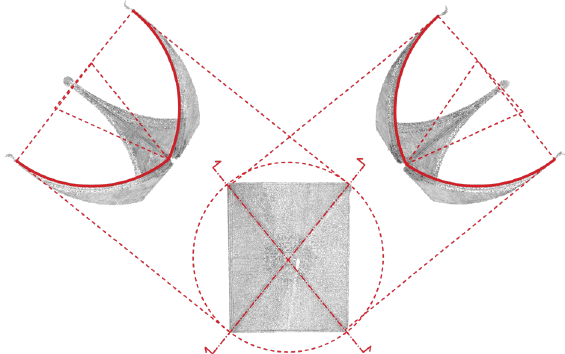
Figure 9 . Definition of curvatures and centres of diagonal arches of one of the vaults of San